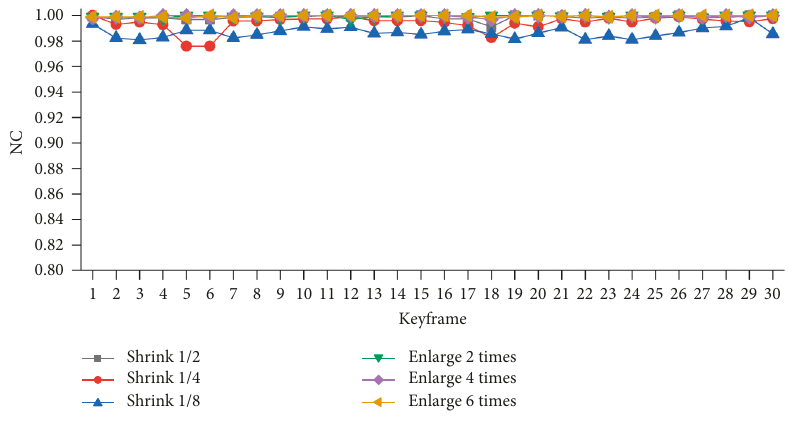
Figure 14: NC value under scaling attack.